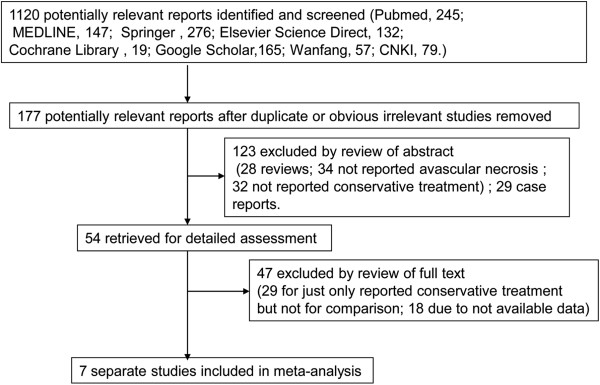
Flow diagram of the study selection process.